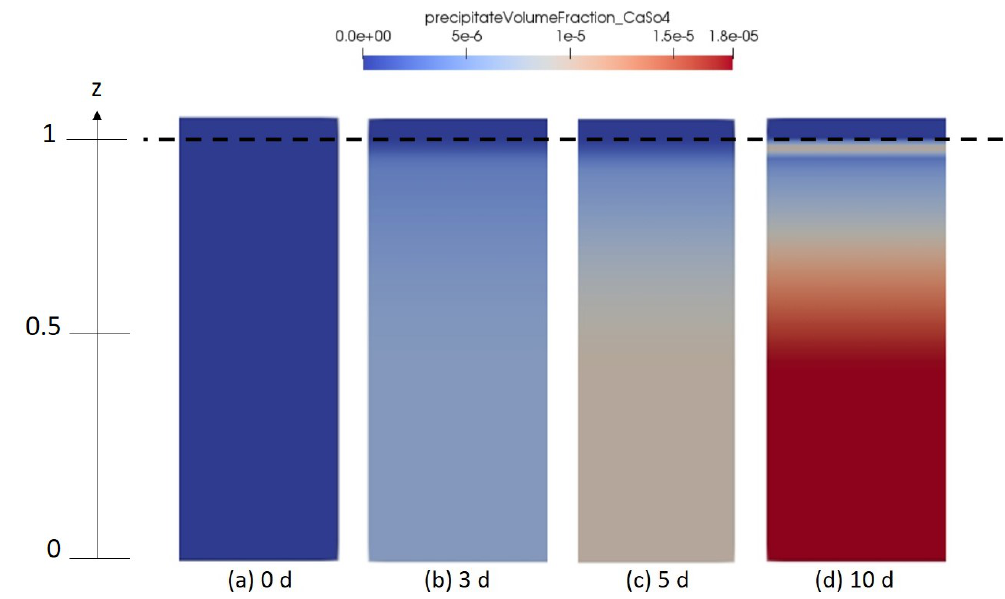
Figure 10. Numerical results depicting the spatial distribution of gypsum solidity in the porous